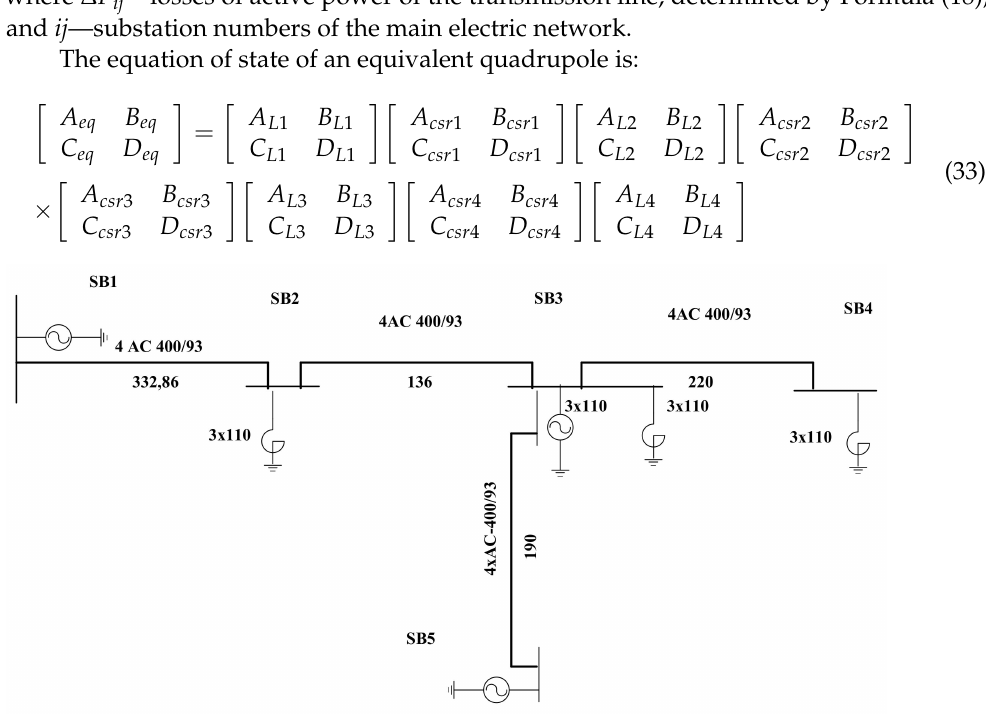
Figure 2. Bulk electrical network